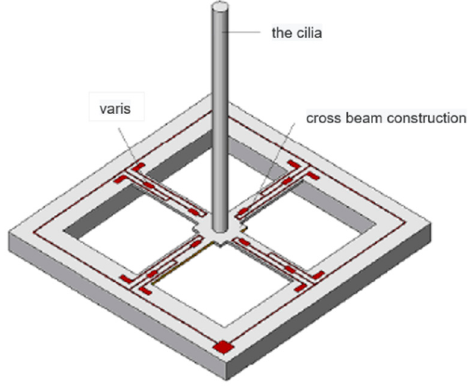
Figure 1. MEMS vector hydrophone microstructure.